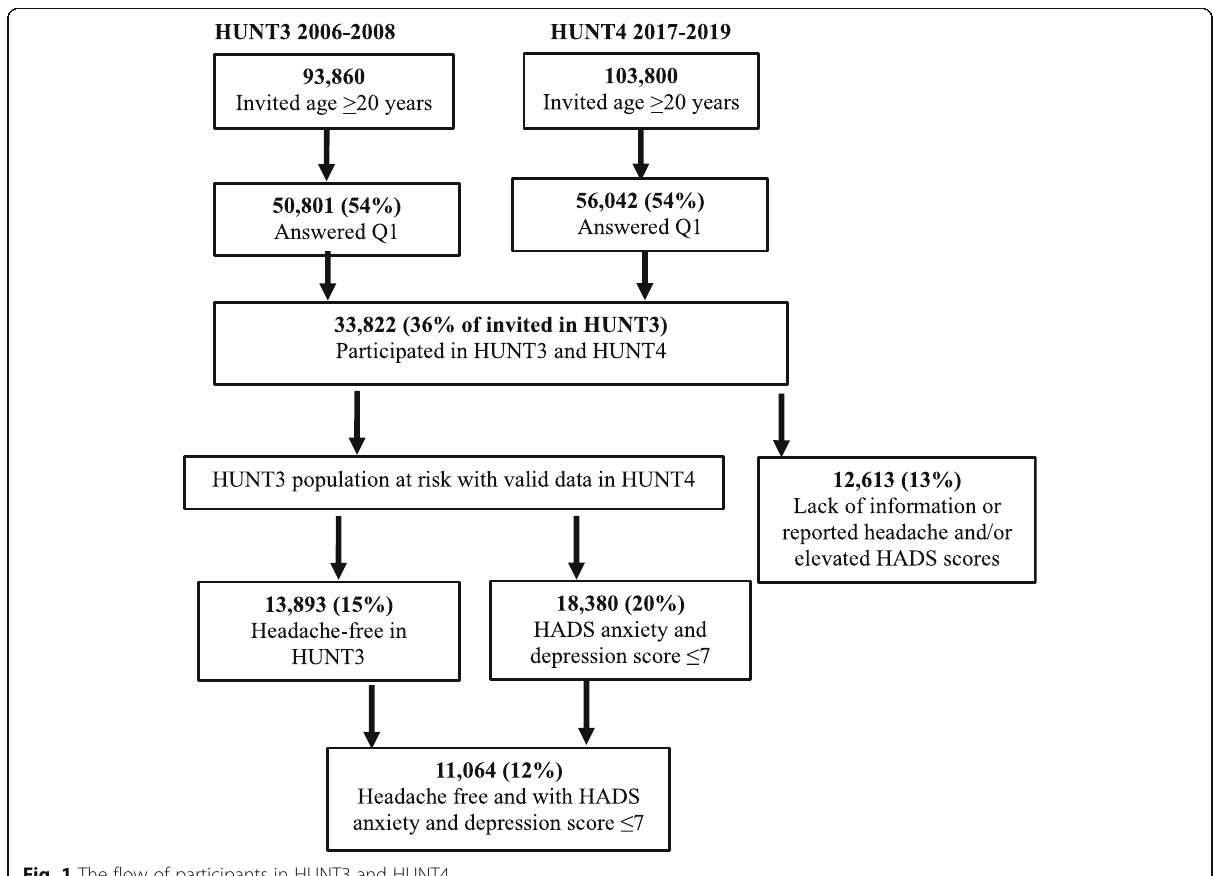
Fig. 1 The flow of participants in HUNT3 and